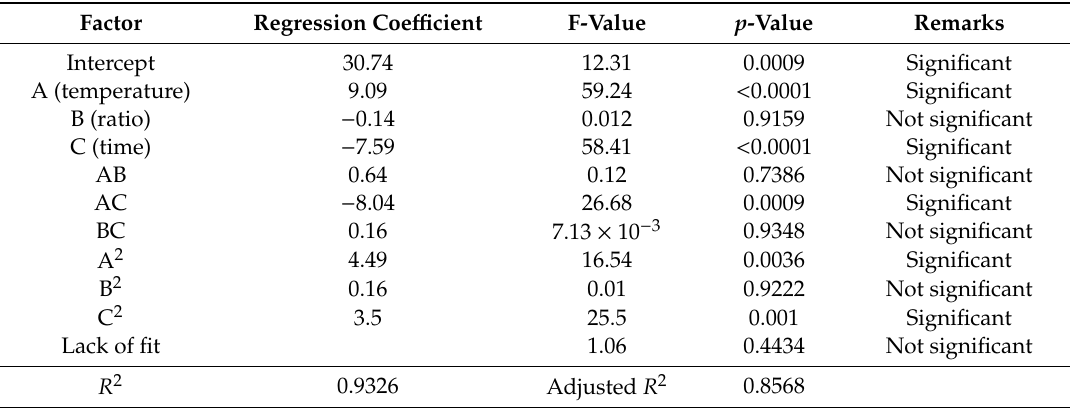
Table 4. Estimation regression coe ffi cient and analysis of variance (ANOVA) for the investigated